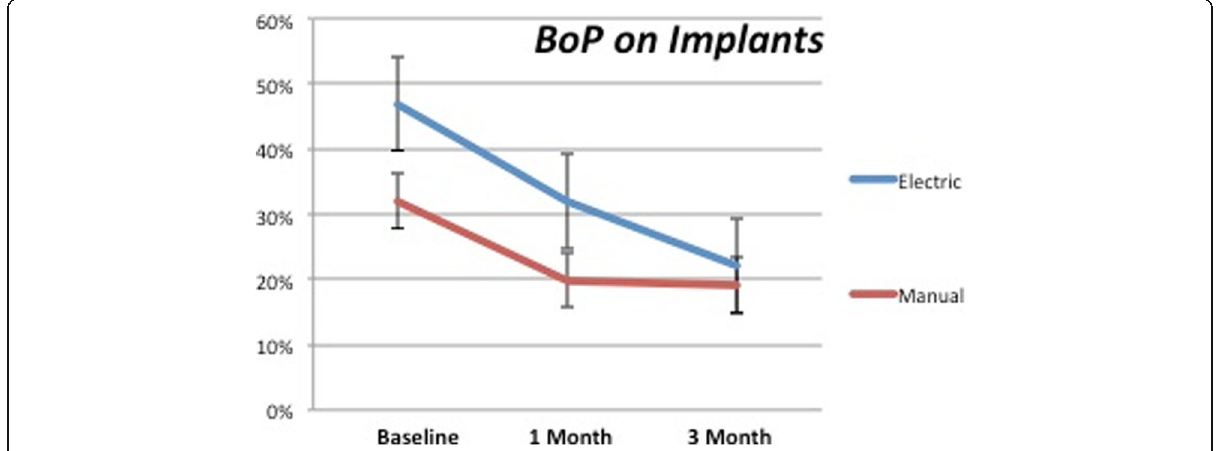
Fig. 5 BoP on dental implants. It can be observed how the values keep decreasing after 1 month only in the test